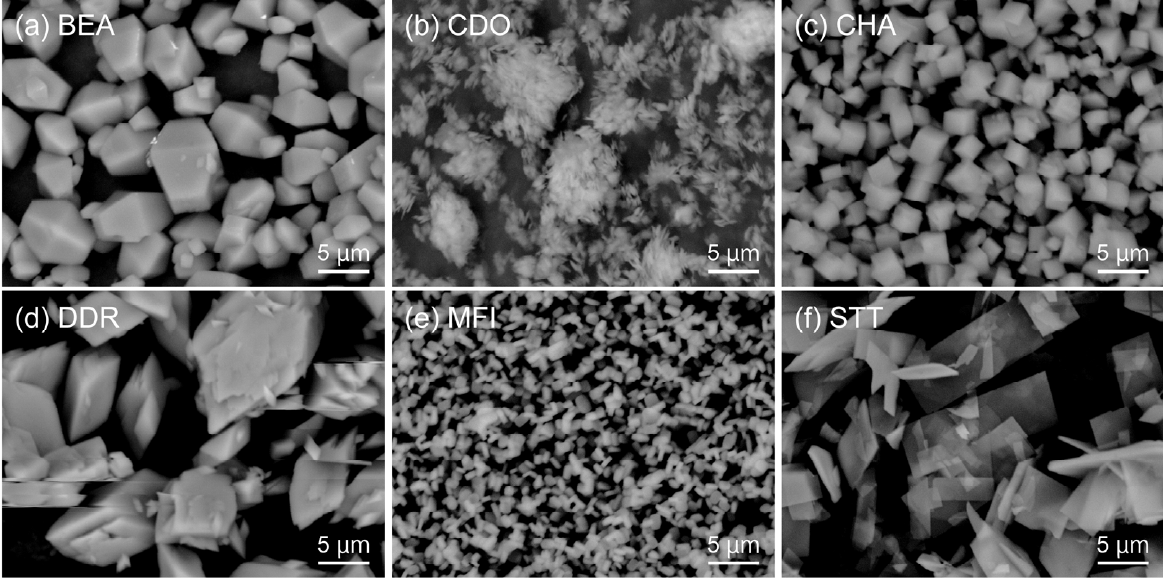
Figure 2. SEM images of all-silica ( a ) BEA, ( b ) CDO, ( c ) CHA, ( d ) DDR, ( e ) MFI, and ( f ) STT-type zeolite particles synthesized in this study.